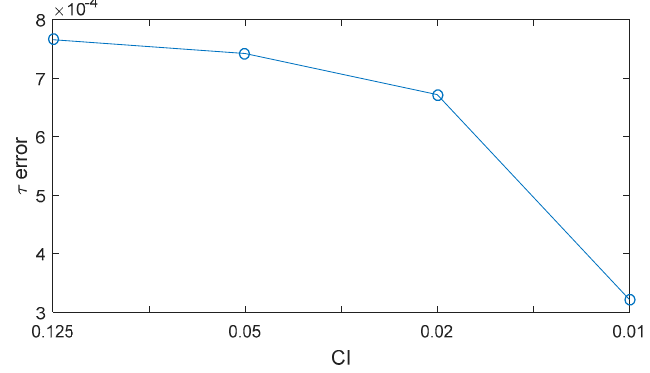
Figure 14. SPE error with respect to CI when D is − 1.